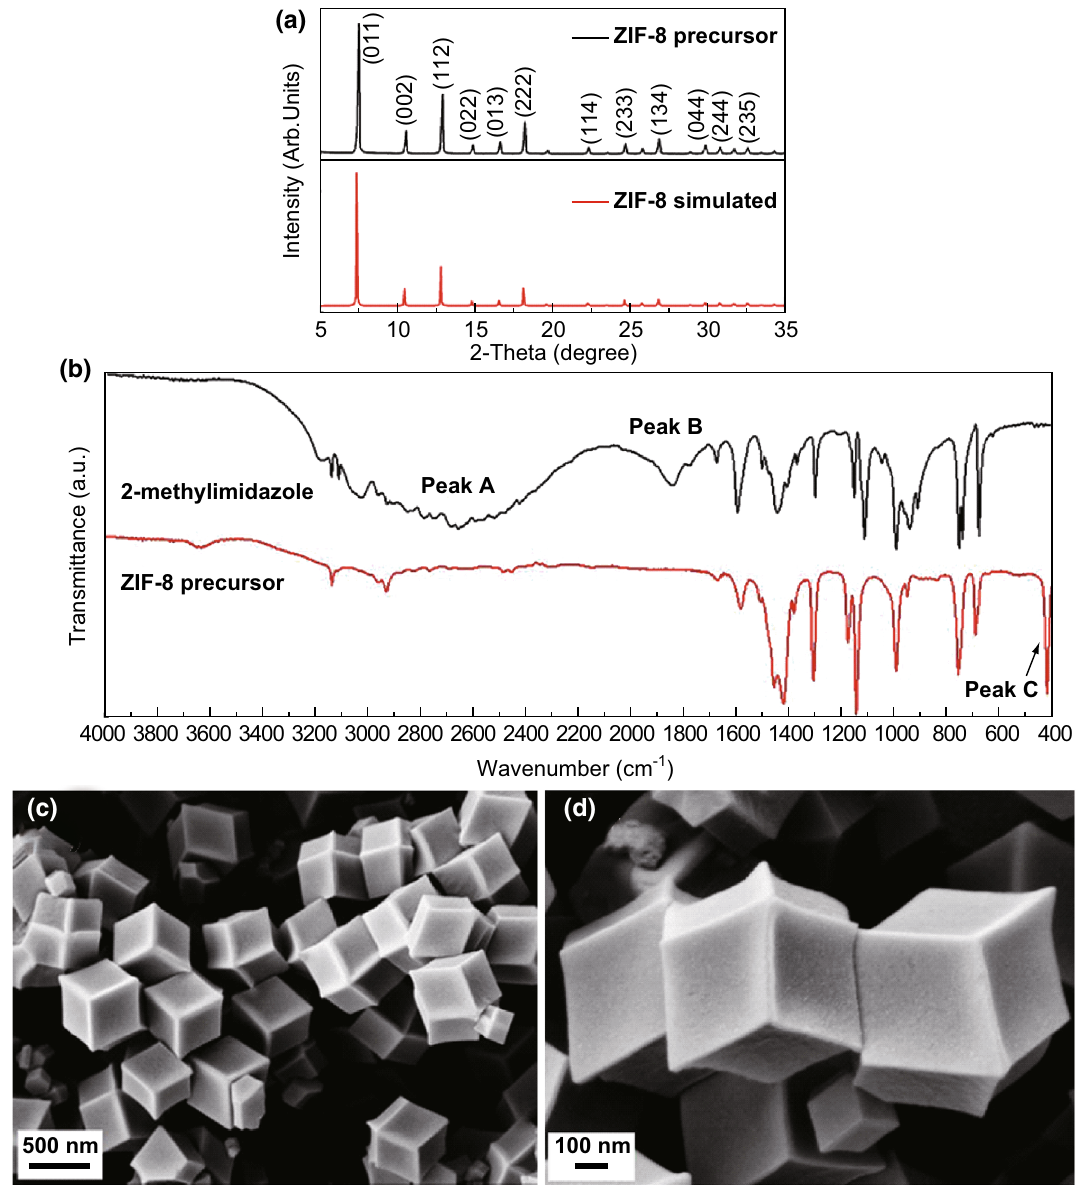
Fig. 3 a XRD pattern, b FTIR spectrum, and c , d SEM images of ZIF-8